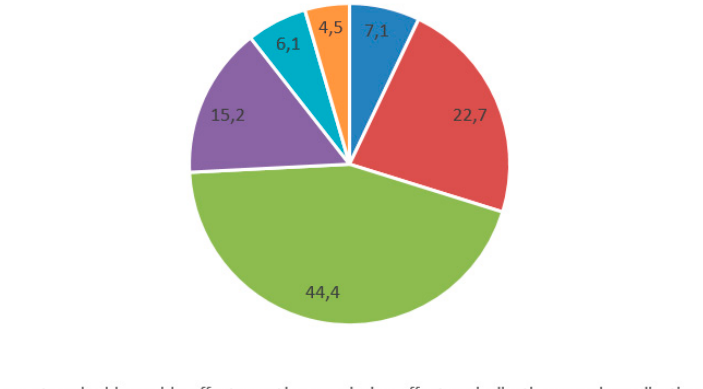
Figure 1. Reasons for changes of medication after discharge.